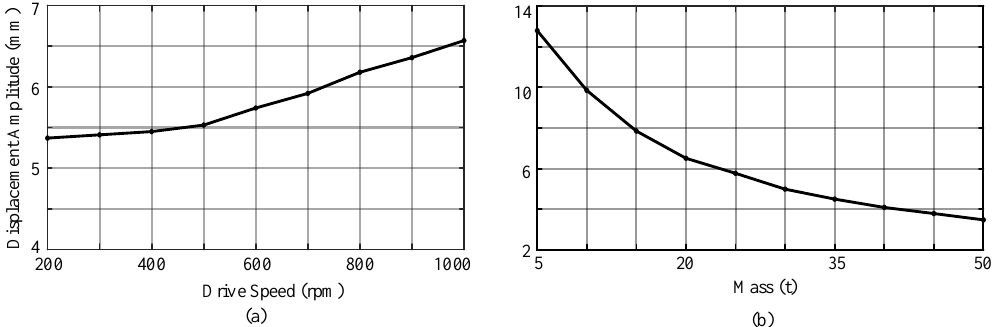
Figure 22. The effect of drive speed and fixed cone mass on displacement amplitude as: ( a ) displacement amplitude for different speeds in the fixed cone mass 24 t case; ( b ) displacement amplitude for different masses in the 600 rpm case.